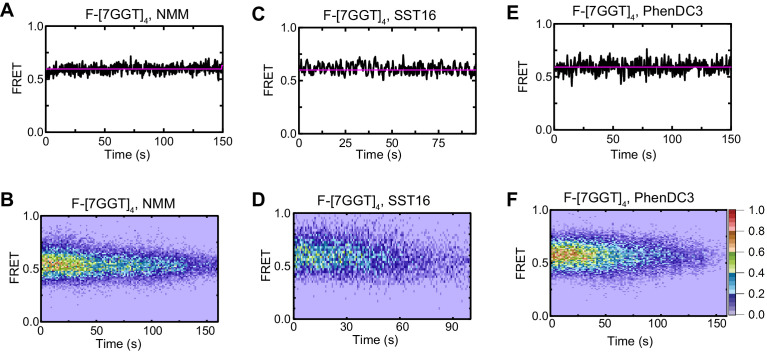
Effects of ligands on F-[7GGT]4 FRET.Representative FRET trajectories (A, C, E) and heat maps (B, D, F) of F-[7GGT]4 in the presence of NMM (10 mM in folding reaction), SST16 (100 µM) or PhenDC3 (1 µM), without telomerase; n = 120 (B), 73 (D), 111 (F), molecules, collected in 4–6 independent experiments. For color key, see panel (F).